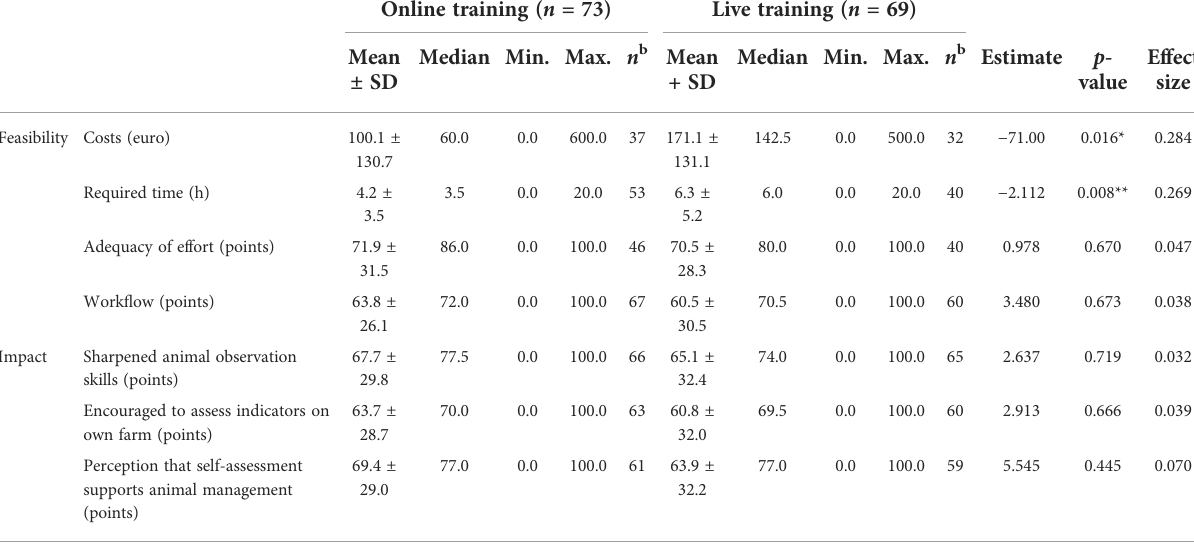
TABLE 5 Farmers ’ ratings of the feasibility and impact of the online and live training (robust mixed model) a